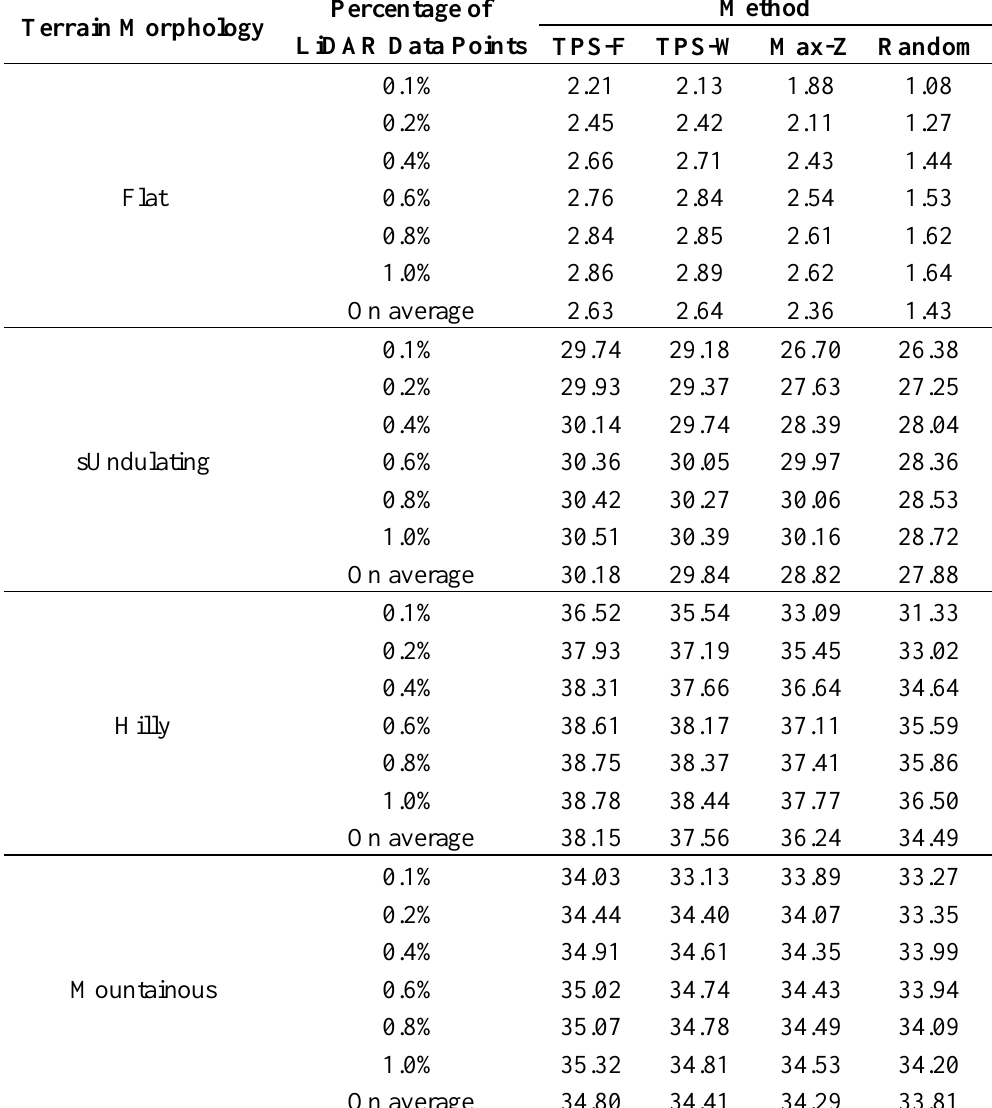
Table 2. Mean slope of TPS-F, TPS-W, max-Z and the random method in the four study sites with different percentages of LiDAR data points (unit: degree